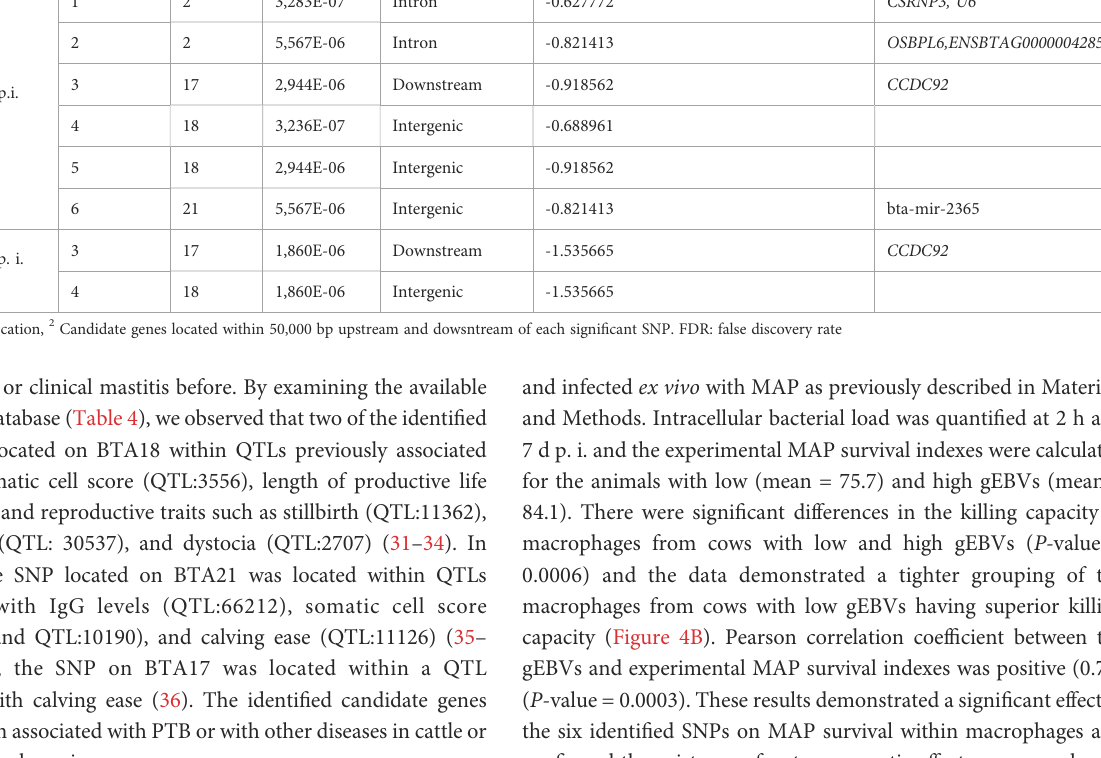
TABLE 3 SNPs surpassing the signi fi cance threshold ( P FDR ≤ 0.05) for evidence of an association with MAP load within infected MDMs at 2 h and 7 d p. i. Phenotype